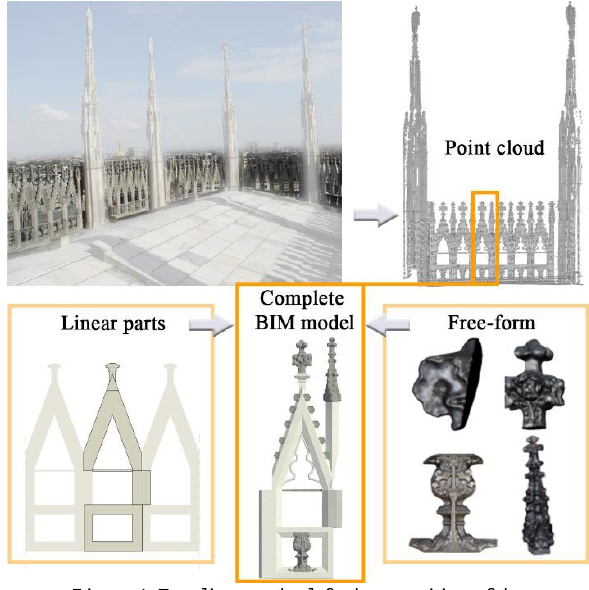
Figure 4. Top line: on the left, the repetition of the “Falconatura” all around the roofs of Milan’s Cathedral; on the right, the cleaned point cloud of a “falconatura” serie. Bottom line: the complete BIM model of one falconatura, which is composed by regular elements (linear) and free-form (complex